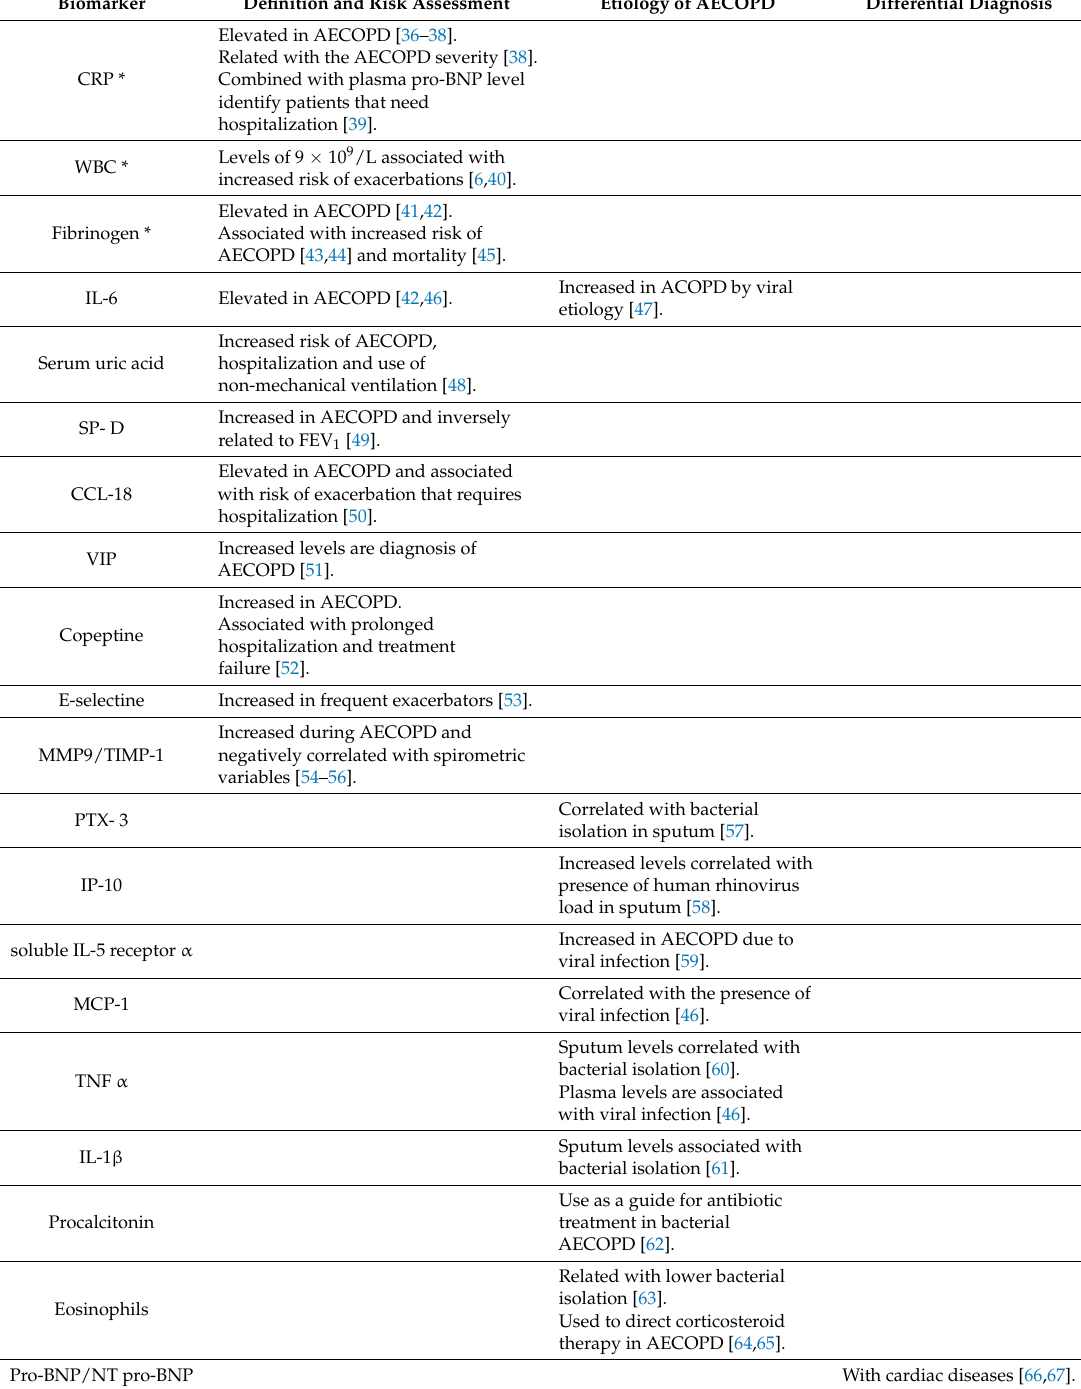
Table 2. Biomarkers in acute exacerbations in COPD according to clinical